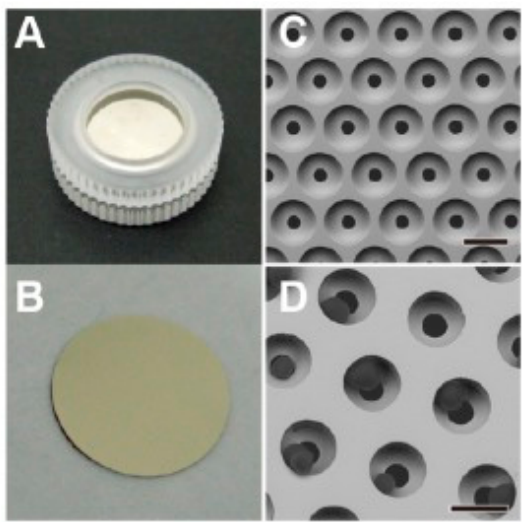
Figure 2. Photographs of the ( A ) 3-dimensional palladium filter cassette and ( B ) filter sandwiched by the upper and lower cassette piece. SEM images of the ( C ) three-dimensional palladium filter and ( D ) tumor cells trapped in the pockets of the filter. (Reprinted from [42]).